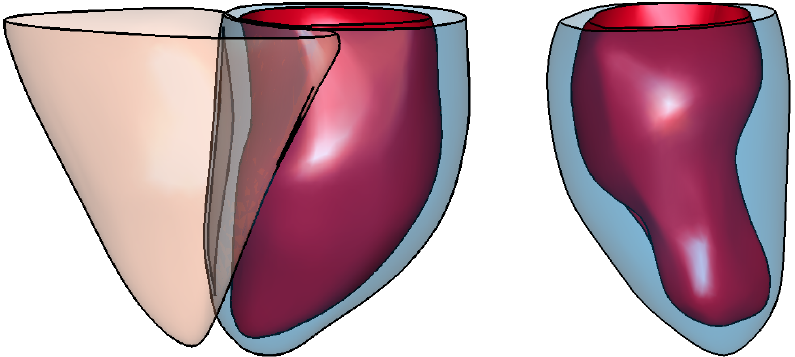
Figure 9. Example of resulting surface meshes generated from ( a ) contours for a normal case, and ( b ) contours belonging to a severe abnormal anatomy. The left panel shows surface meshes for the left endocardial (in red) and epicardial (in blue) ventricle as well as the right epicardial ventricle (in orange). The right panel shows surface meshes for the left endocardial (in red) and epicardial (in blue)